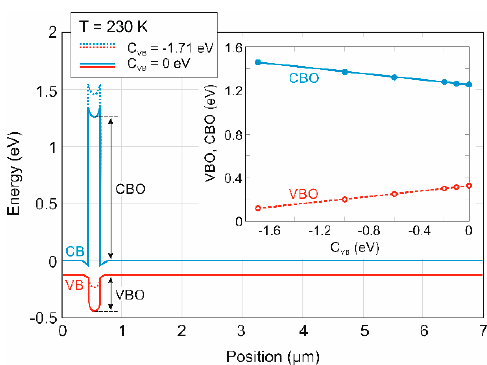
Figure 4. Calculated band structure for the nBn T2SL detector operated at 230 K. Inset: The VBO and CBO between the AL and the AlAs 0.15 Sb 0.85 BL as a function of the VB bowing parameter for AlAsSb.